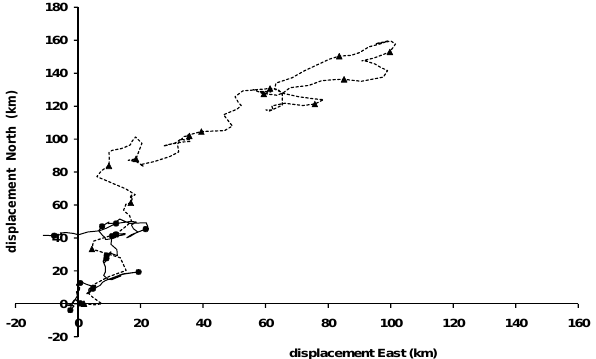
Fig. 3. Progressive vector diagram for Oyster Grounds for May to September 2007. Solid line is 5m above seabed, dashed line is 37m above seabed. Markers identify every tenth day at each depth.